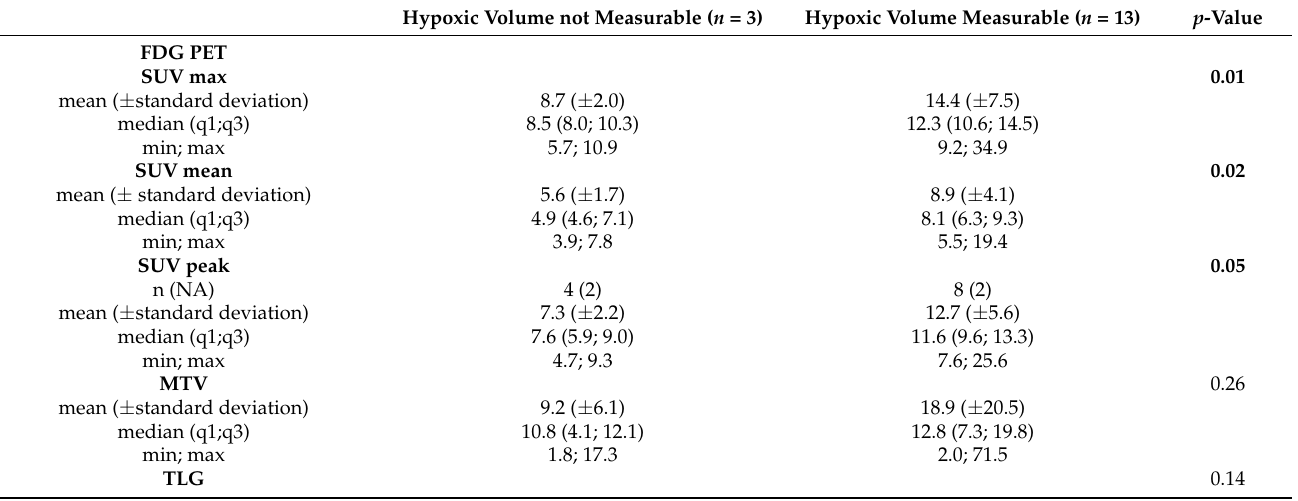
Table 4. Non-parametric Wilcoxon tests for independent data between patients with and without measurable hypoxic